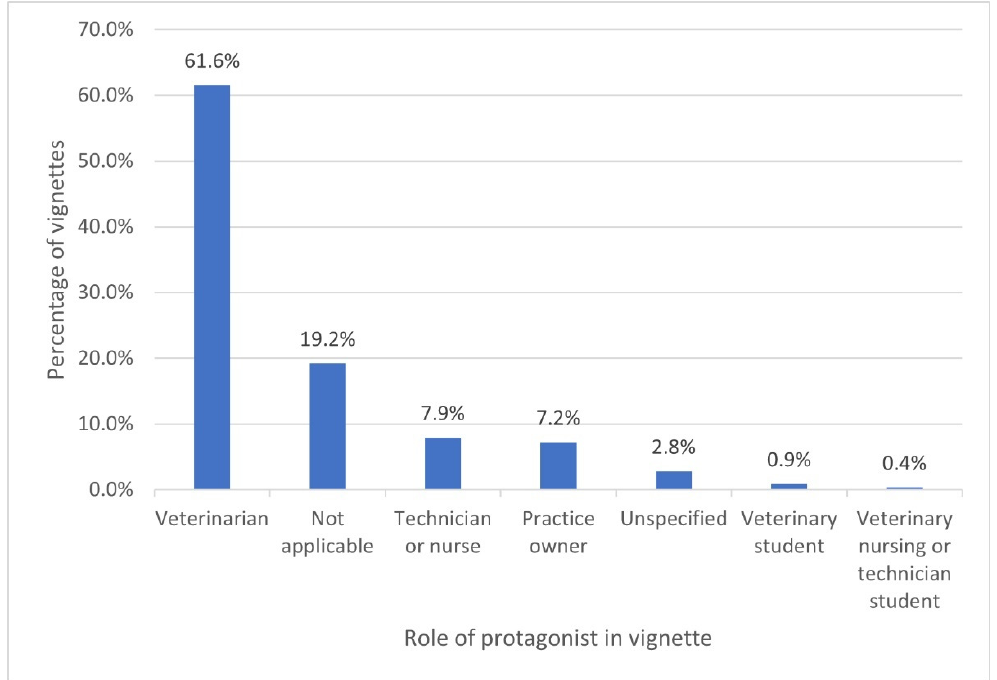
Figure 2. Bar chart depicting the role of the protagonist in ethical vignettes ( n = 567).